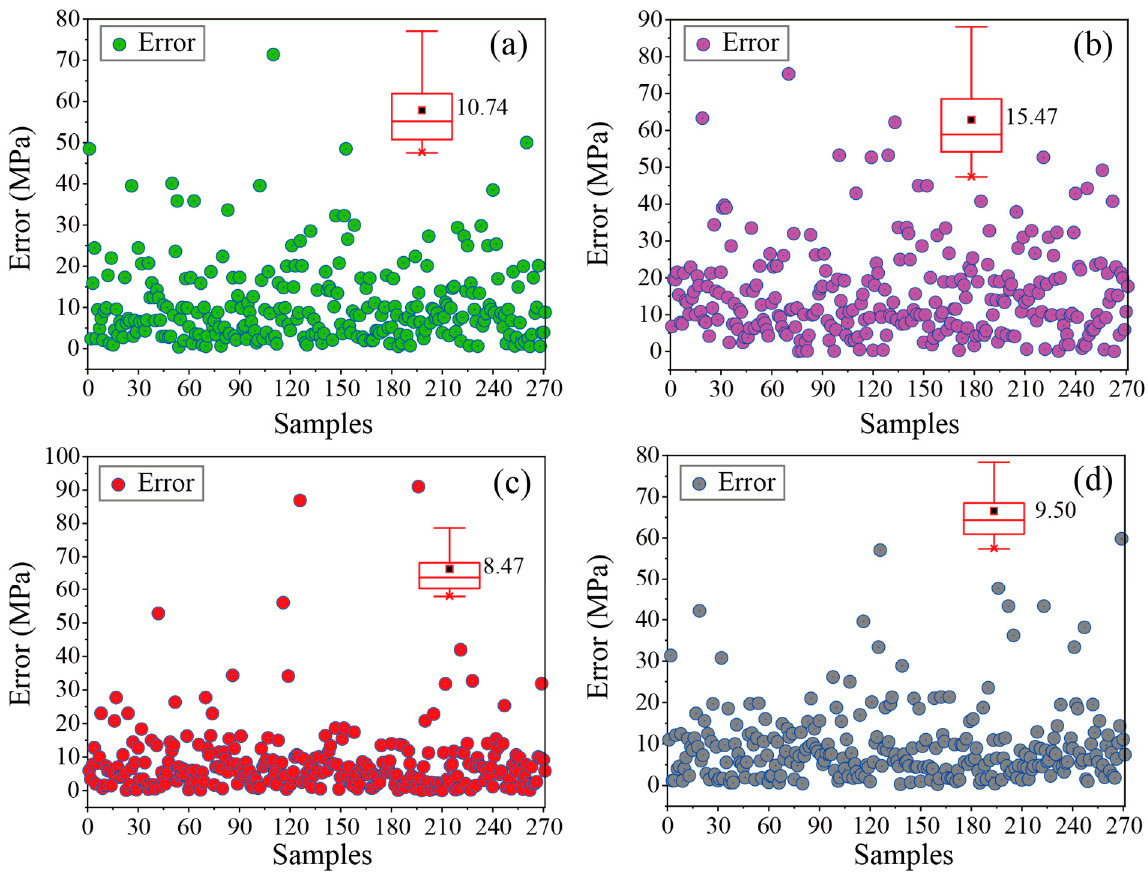
Figure 13. The distribution of error for various input variables with KELM-GWO model: ( a ) PLS; ( b ) P n ; ( c ) V p ; ( d ) SHR.